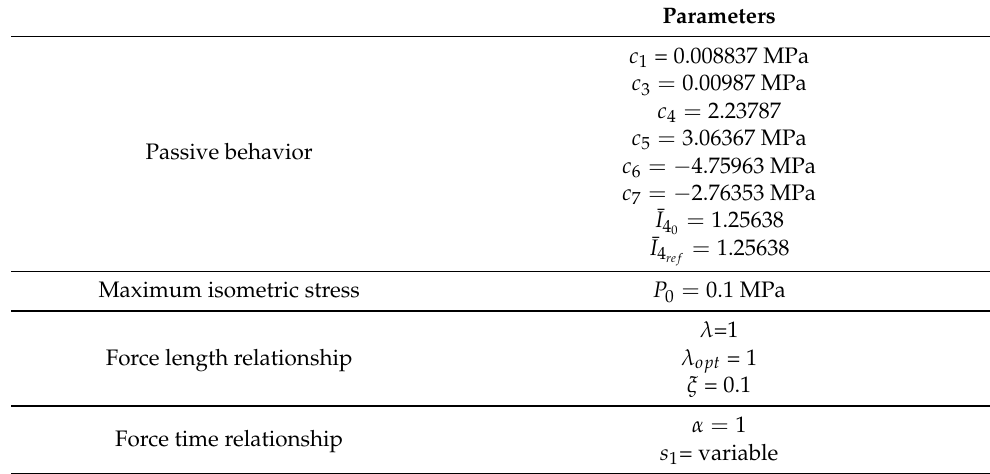
Figure 2. Finite element mesh of the right eyeball, the EOMs and the zones of tendinous insertions obtained from Mitsuhashi et al. [24] incorporating connector elements to simulate the action of soft tissue pulleys. Table 2. Parameters considered in the model for the material behavior of the skeletal-muscle tissue